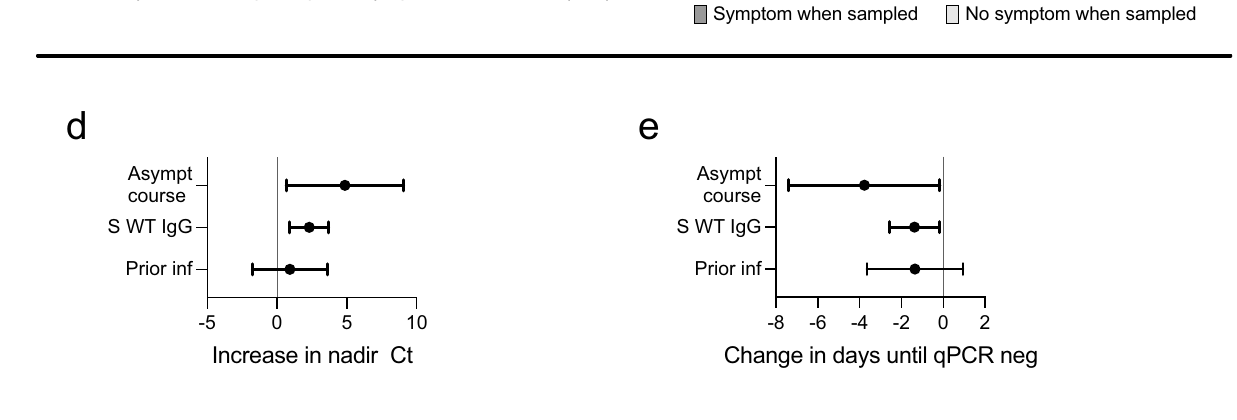
prior SARS-CoV-2 infection and ( e ) change in days until viral clearance (qPCR neg test) by asymptomatic course of infection, per two-fold increase in WT spike- speci fi c IgG levels and prior SARS-CoV-2infection.Estimates in d and e are derived from linear regression models and error bars depict 95% con fi dence interval. Ct Cyclicthreshold,qPCRqualitativepolymerasechainreaction,pospositive,asympt asymptomatic, S WT serum spike-speci fi c wild type, inf infection. Source data are provided as a Source Data fi